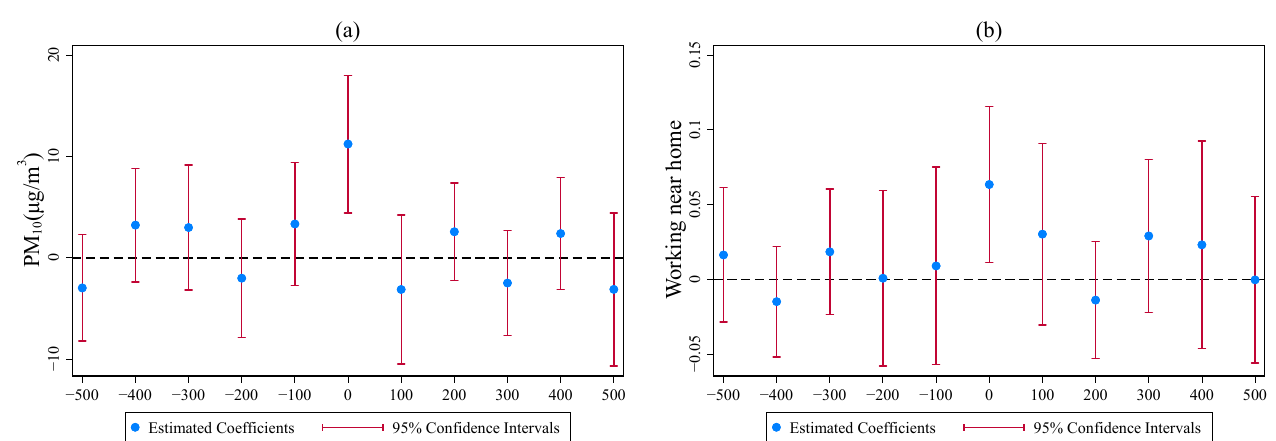
Figure A3. Placebo testing: estimated discontinuity in pollution at displaced Huai River boundaries. Notes: In ( a ), each point plots the point estimate of a separate estimation of α 1 in Equation (2) along with the 95 percent confidence interval at the displaced Huai River boundaries. In ( b ), each point plots the point estimate of a separate estimation of δ 1 in Equation (3) along with the 95 percent confidence interval at the displaced Huai River boundaries. Each RD estimates is based on the MSE bandwidth selection method and triangular kernel function.